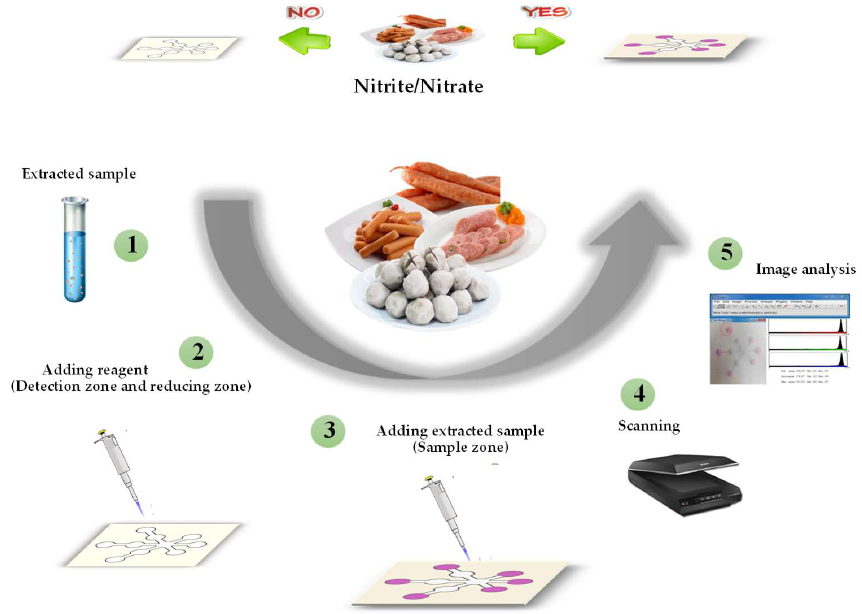
Figure 2. Schematic diagram of the detection assay for nitrite and nitrate in food samples based on colorimetric µ